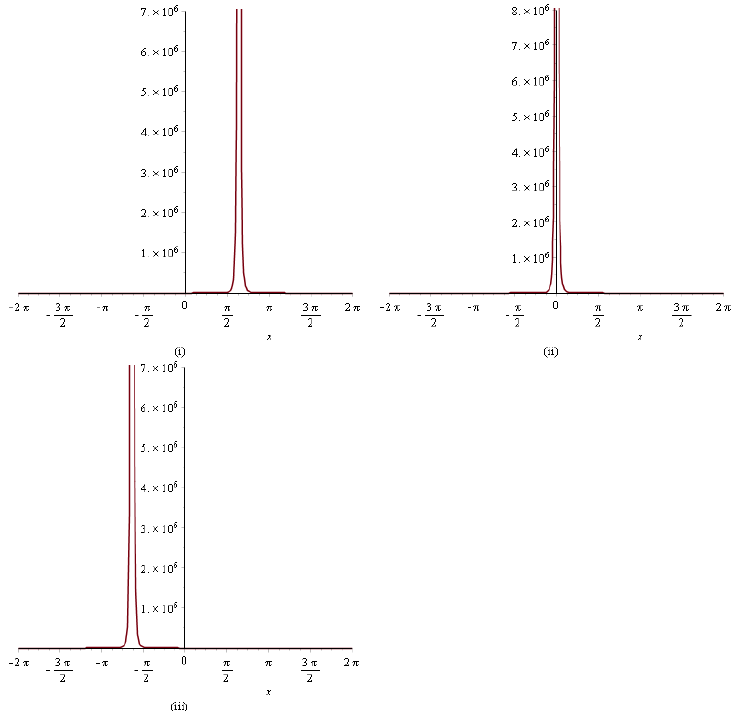
Figure 4. The 2D profiles of solution u s ,1 ( x + ν t ) of Equation (1) corresponding to ( i ) x 0 = 1, t 0 =